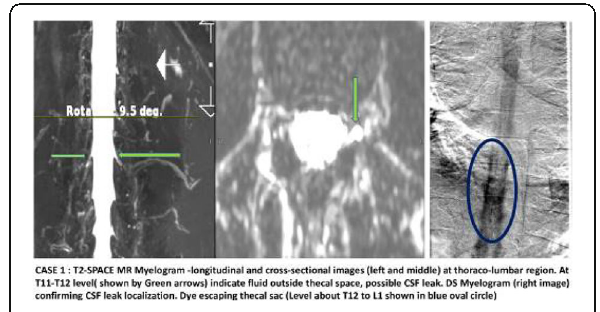
Fig. 1 (abstract P0253). See text for